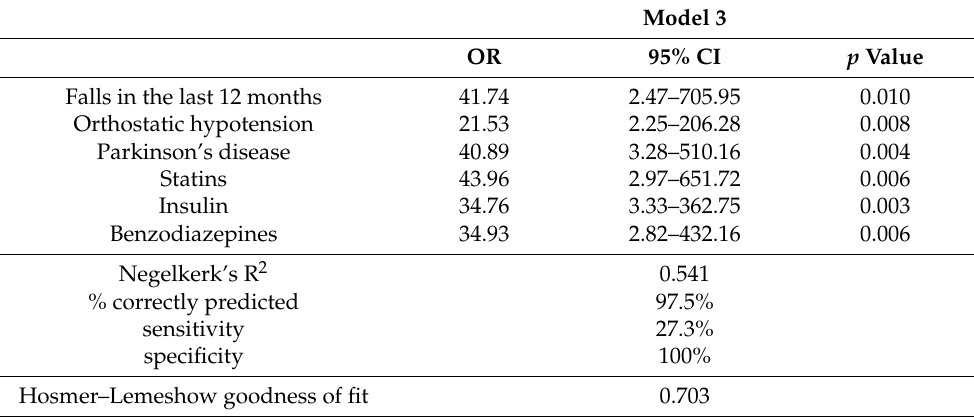
Table 6. Predictors of falls—the final multivariable logistic regression model (enter